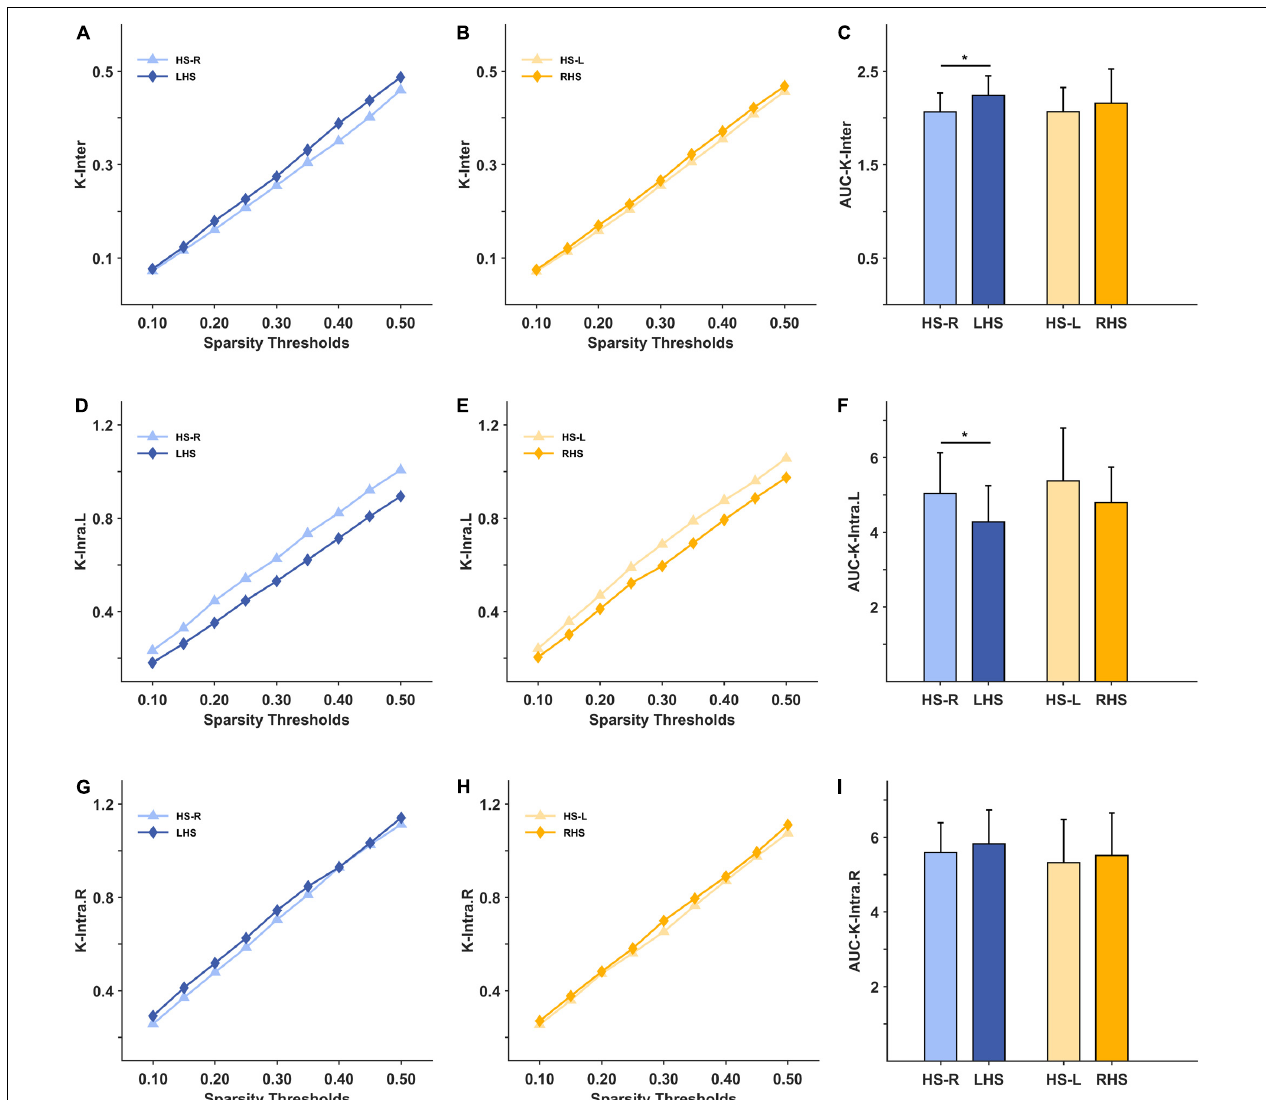
FIGURE 4 | The mesoscale brain network indicators under 10–50% sparsity and their area under curves (AUCs) for patients and healthy subjects (HS). (A) The inter-density under 10%–50% sparsity for HS group (right hand task) and LHS group; (B) the inter-density under 10%–50% sparsity for HS group (left hand task) and RHS group; (C) the AUCs over the whole sparsity range for the inter-density in the HS, LHS and RHS groups. (D–F) are for the indicator intra-density of left hemisphere; (G–I) are for the indicator intra-density of right hemisphere. * p < 0.05.